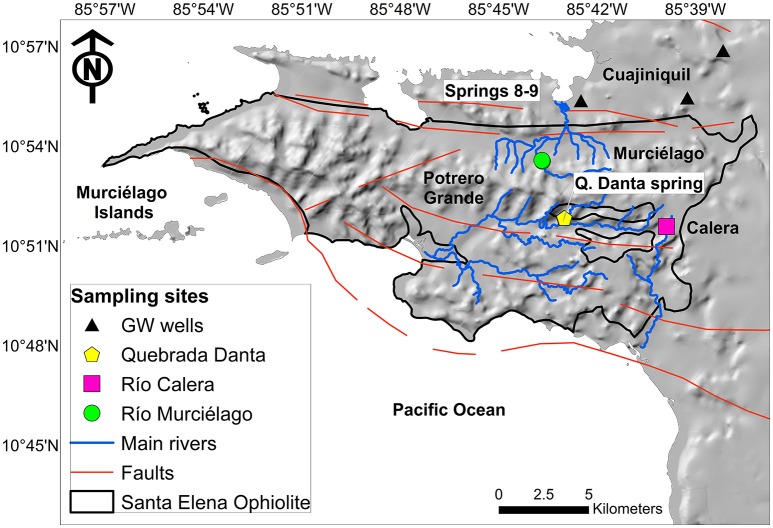
Map of the study area. The bold-black line denotes the Santa Elena Ophiolite boundary, dominated by ultramafic mantle rocks based on Gazel et al. (2006). Sample locations are color-coded: alkaline spring systems within Murciélago and Potrero Grande watersheds are identified by green and yellow symbols, respectively; black triangles denote groundwater wells; pink square stands for a control surface water site. Blue and orange lines are the main perennial rivers and faults, respectively.